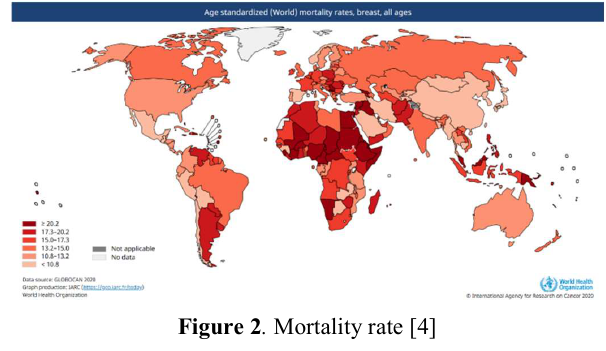
Figure 2 . Mortality rate